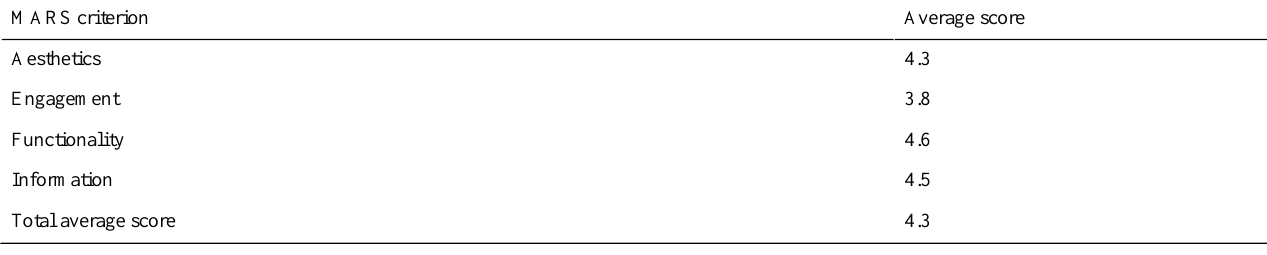
Table 2. Average (out of 5) Mobile Application Rating Scale (MARS) scores for each category applied to the Milk Man breastfeeding